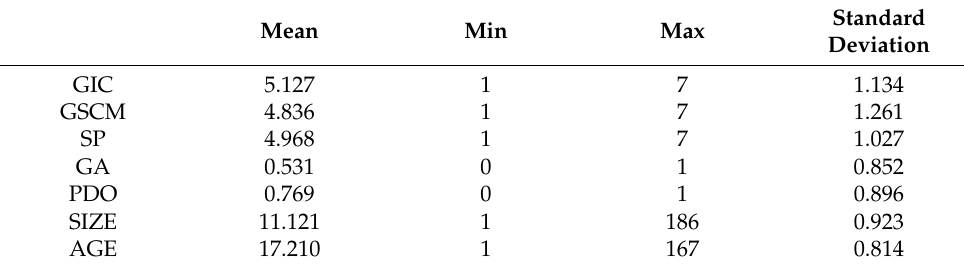
Table 1. Values of the mean, minimum value, maximum value and standard deviation of the variables analyzed.